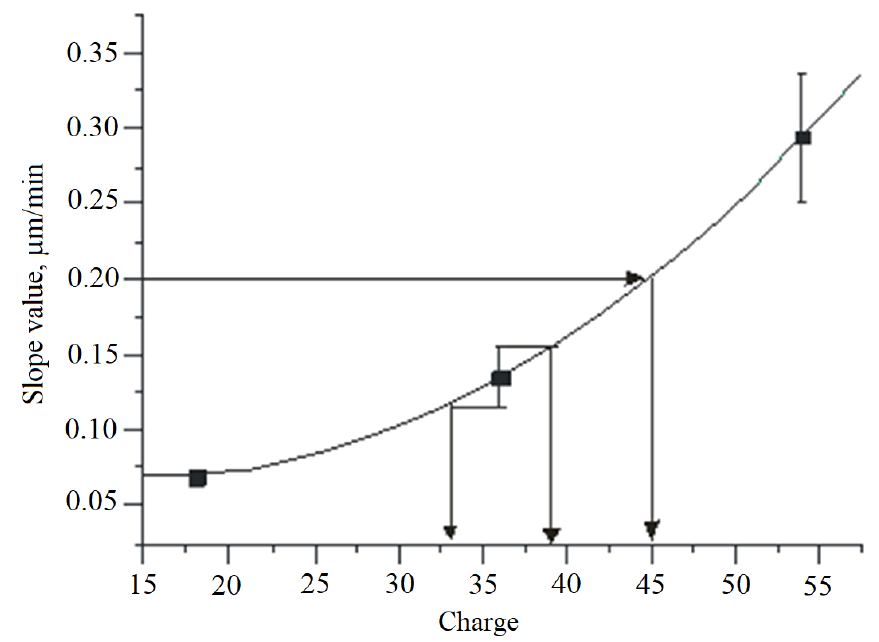
Figure 5. Algorithm for the ion charge determining. (No color)